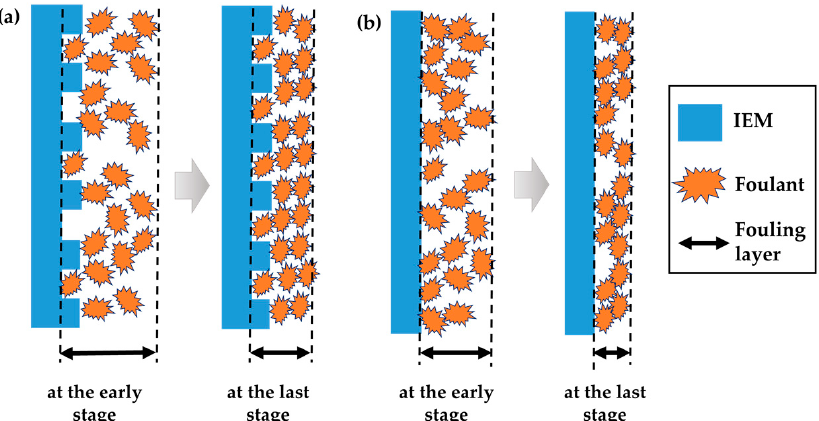
Figure 6. Illustration of describing the change in the fouling behavior on ( a ) the Fujifilm ® IEMs with the rough and hydrophilic surface and ( b ) the lab-made IEMs with the smooth and hydrophilic surface at the early (left-hand side) and the last stage (right-hand side) for 500 h immersing in the SDBS_348_AS + 0.017 M NaCl.